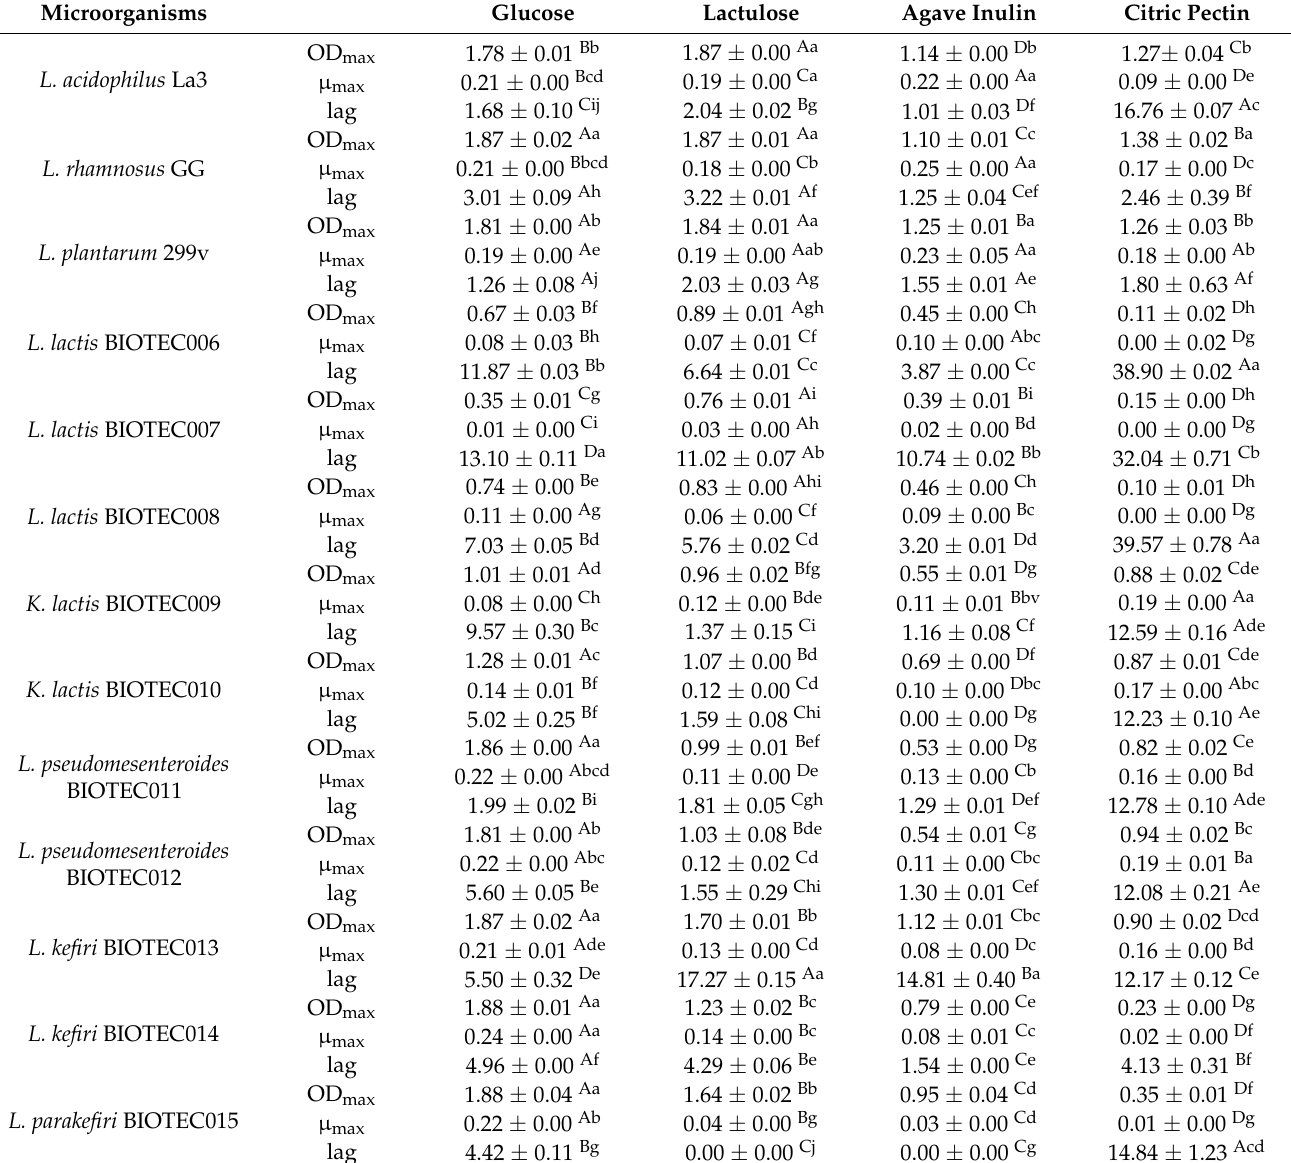
Table 7. Maximum optical density at 600 nm (ODmax), maximum growth rate ( µ max, h − 1 ), and lag (h) parameters of bacteria growing under aerobic conditions on glucose, lactulose, agave inulin, and citric pectin as carbon sources. Microorganisms Glucose Lactulose Agave Inulin Citric